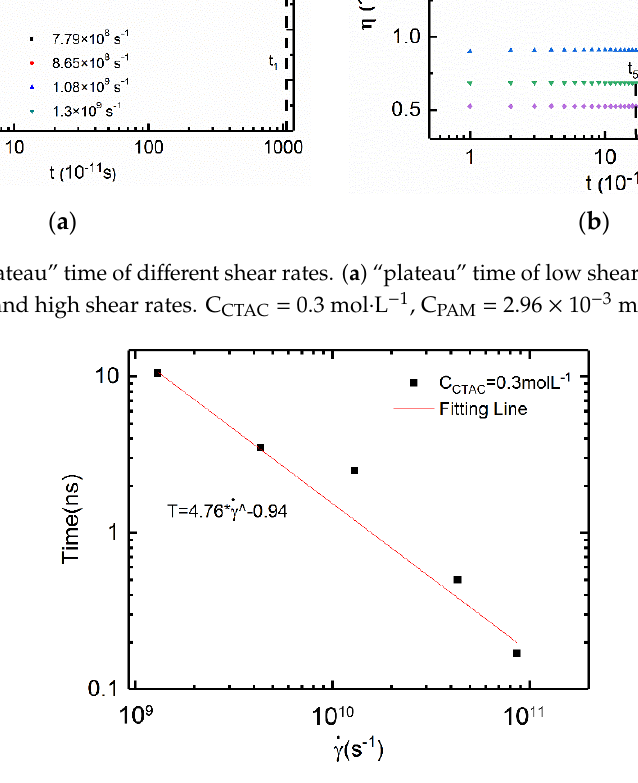
Figure 9. The relation between the shear rates and characteristic time.